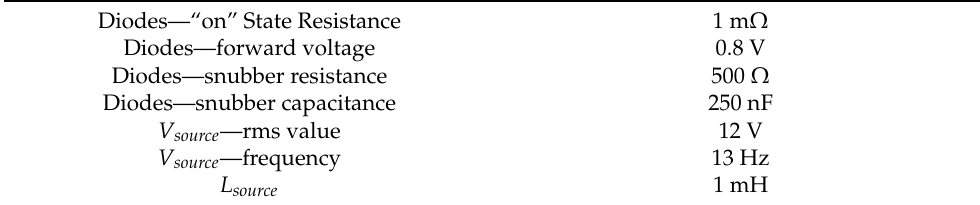
Figure 7. Equivalent circuit of the dynamo flux pump supplying the field winding of the HTS genera- tor. Table 3. Dynamo flux pump — equivalent circuit parameters. Table 3. Rectifier flux pump—equivalent circuit